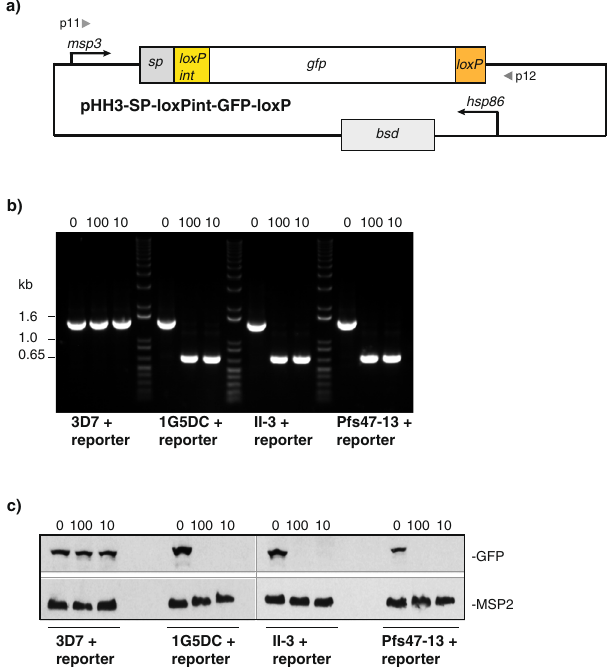
Figure 4. The new transgenic parasite lines excise floxed DNA sequences efficiently. ( a ) Schematic of reporter plasmid pHH3-SP-loxPint-GFP-loxP. The gfp ORF is flanked by a loxPint site upstream and a loxP site downstream. Transcription is driven by 1258 bp of msp3 5 ′ UTR sequence. SP, 110 bp of signal peptide-encoding sequence from msp3 ; bsd , blasticidin S deaminase driven by hsp86 promoter. 3D7, and the DiCre-expressing parasite lines 1G5DC, II-3 and Pfs47-13 were transfected with the reporter plasmid and selected using 2.5 µ g/ml blasticidin. ( b ) PCR amplification of the GFP cassette using primers 11 and 12 showing successful recombination after rapamycin treatment. The expected product size is 1471 bp before excision and 670 bp following excision. Treatment conditions were either 0.05% DMSO (0), 100 nM rapamycin for 4 h (100) or 10 nM rapamycin for 1 h (10) as indicated on the top of each lane. The parasite lines treated are indicated at the bottom of the panel. DNA marker sizes are shown on the left. ( c ) Immunoblots showing the lack of a 27 kDa GFP band after rapamycin treatment. The four parasite lines transfected with the reporter plasmid were treated with DMSO or rapamycin as indicated on the top of each panel and described in section b). Treatment occurred at early ring stage and schizonts were harvested by Percoll gradient 38–40 h later before separation on SDS- PAGE and immunoblotting. Anti-GFP and anti-MSP2 antibodies were used as indicated on the right of the